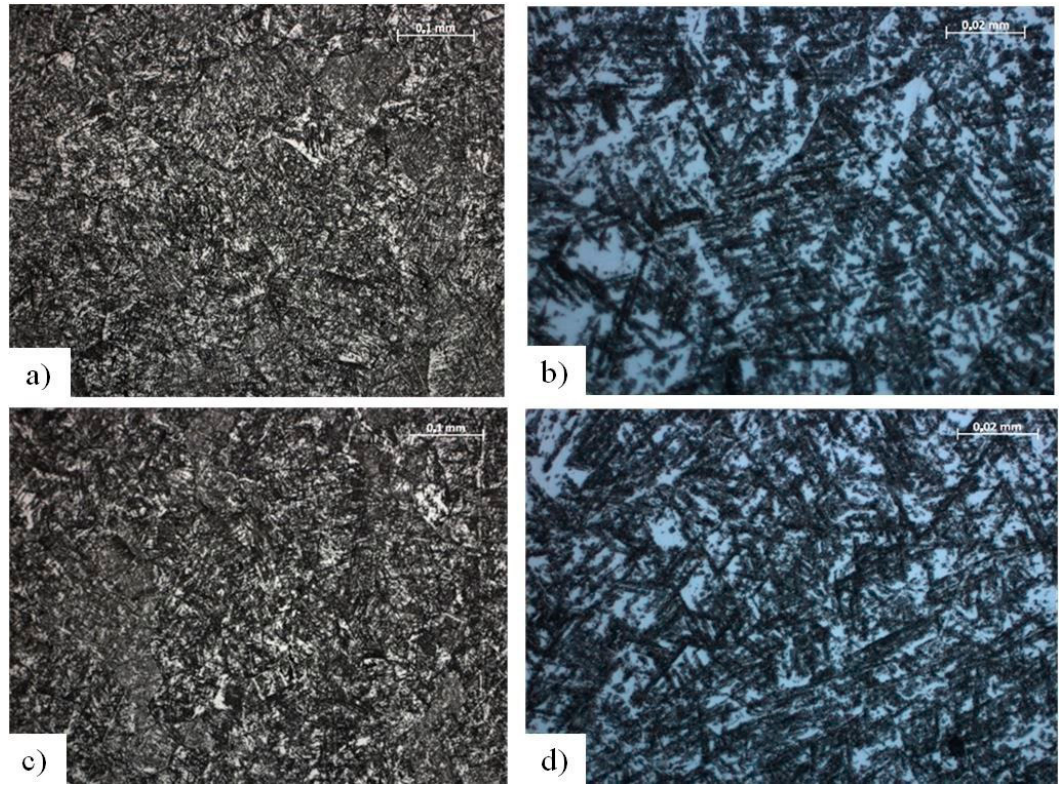
Figure 1. The microstructure of the Ti ‐ 13Nb ‐ 13Zr alloy ( a ) Polished longitudinal section, mag. 200×; ( b ) Polished longitudinal section, mag. 1000×; ( c ) Polished transverse section, mag. 200×; ( d ) Polished transverse section, mag. 1000×.